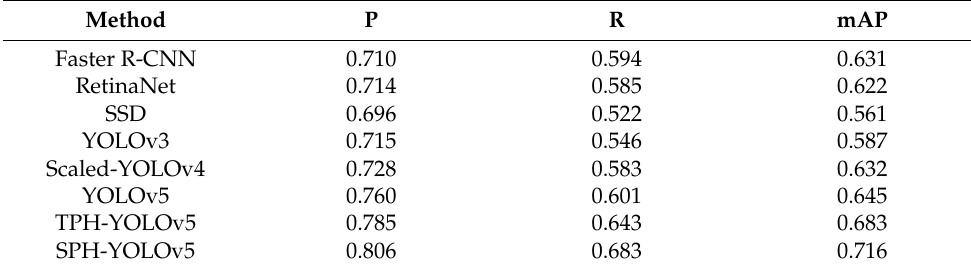
Table 3. Test results on the DOTA test dataset for different detection